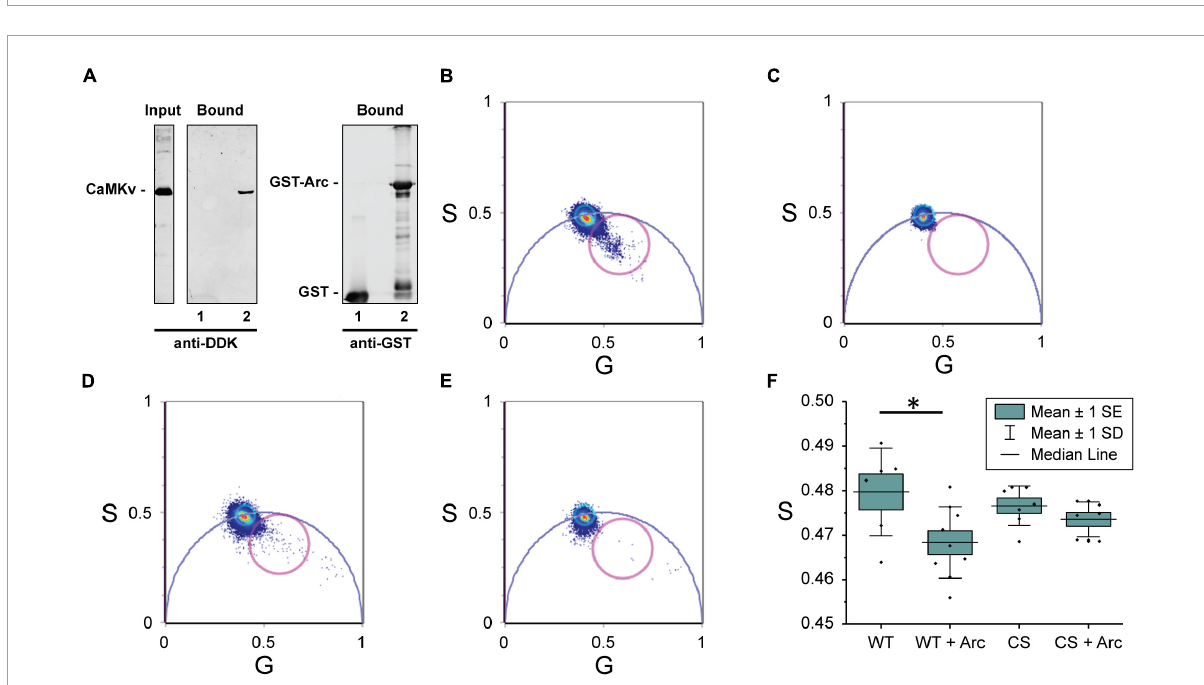
FIGURE4 Interaction of calmodulin kinase-like vesicle-associated (CaMKv) with Arc (A) CaMKv binding to GST-Arc (see “Materials and methods” section). HeLa cell extract expressing CaMKv-myc-DDK was incubated with purified GST (control) or GST-Arc (10 µ M) with glutathione beads. Samples were centrifuged and pelleted proteins were electrophoresed and blotted with anti-DDK or anti-GST. Lane 1: GST alone (control); Lane 2: GST-Arc. Input represents 20% of CaMKv in the incubation mixture. Similar results were obtained in three separate experiments. (B–F) FRET/FLIM analysis. Phasor plot pixel lifetime distribution of cells expressing: (B) wild-type-CaMKv-EGFP and Arc-mCherry, (C) wild-type CaMKv-EGFP (donor alone), (D) C5S-CaMKv-EGFP and Arc-mCherry, and (E) C5S-CaMKv-EGFP (donor alone). Points within magenta circles represent pixels in which reduction of donor lifetime (i.e., FRET) is observed. (F) Quantification of data in Figures 4B–E . Asterisk indicates significant difference ( p < 0.05) using Mann-Whitney nonparametric